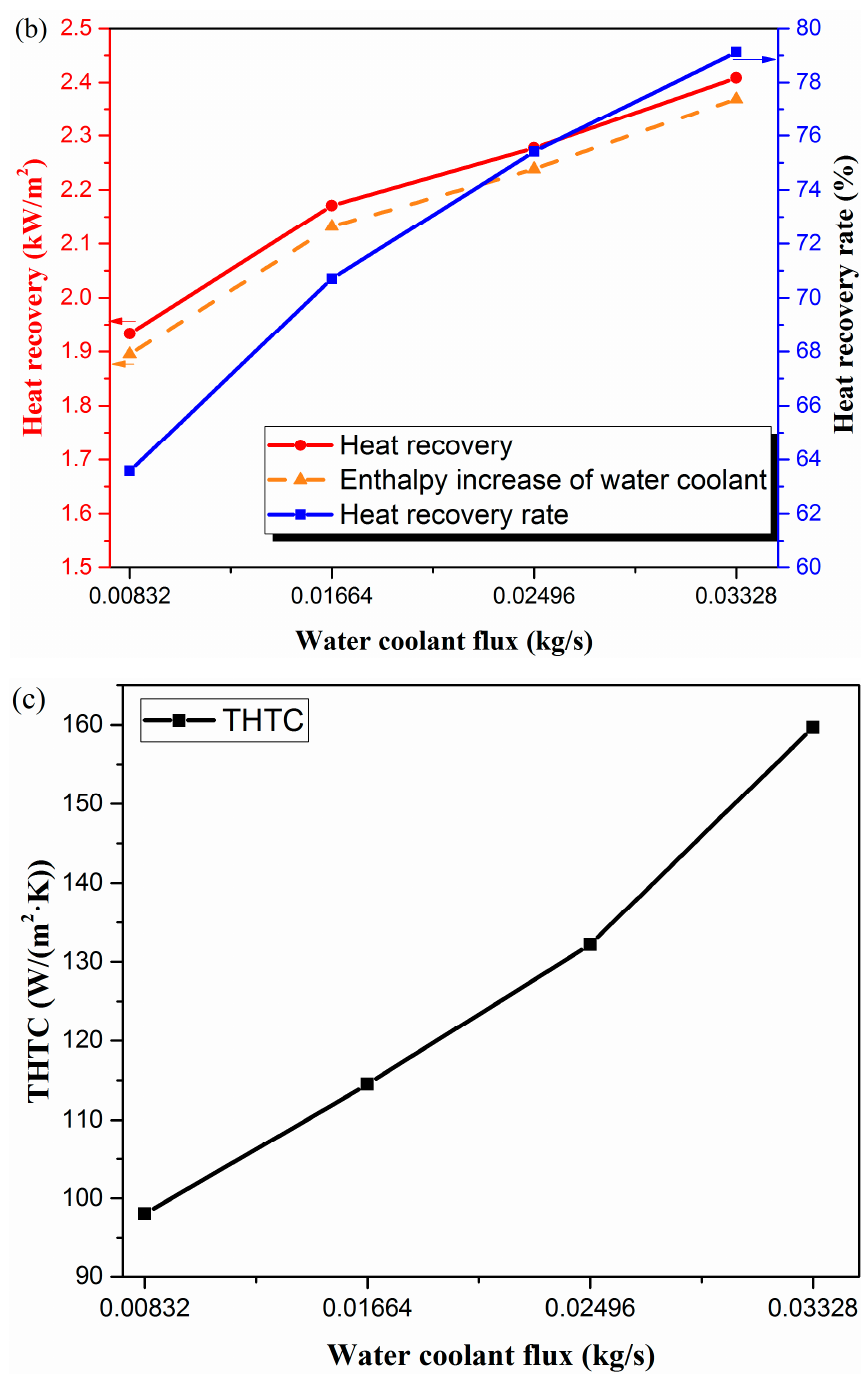
Figure 6. Figure 6. Membrane performance changes with water coolant flux in terms of ( a ) water, ( b ) heat, and ( c ) THTC. (Experimental conditions: flue gas flow rate 1.875 × 10 − 4 kg/s, flue gas temperature 50 °C, water coolant temperature 20 °C).